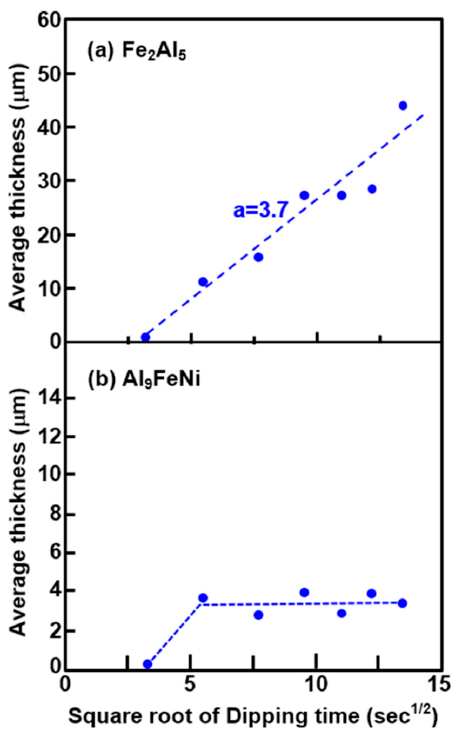
Figure 12. Change in thickness of ( a ) Fe 2 Al 5 ( η ) phase and ( b ) Al 9 FeNi (T) phase as function of the square root of dipping time (s 1/2 ).